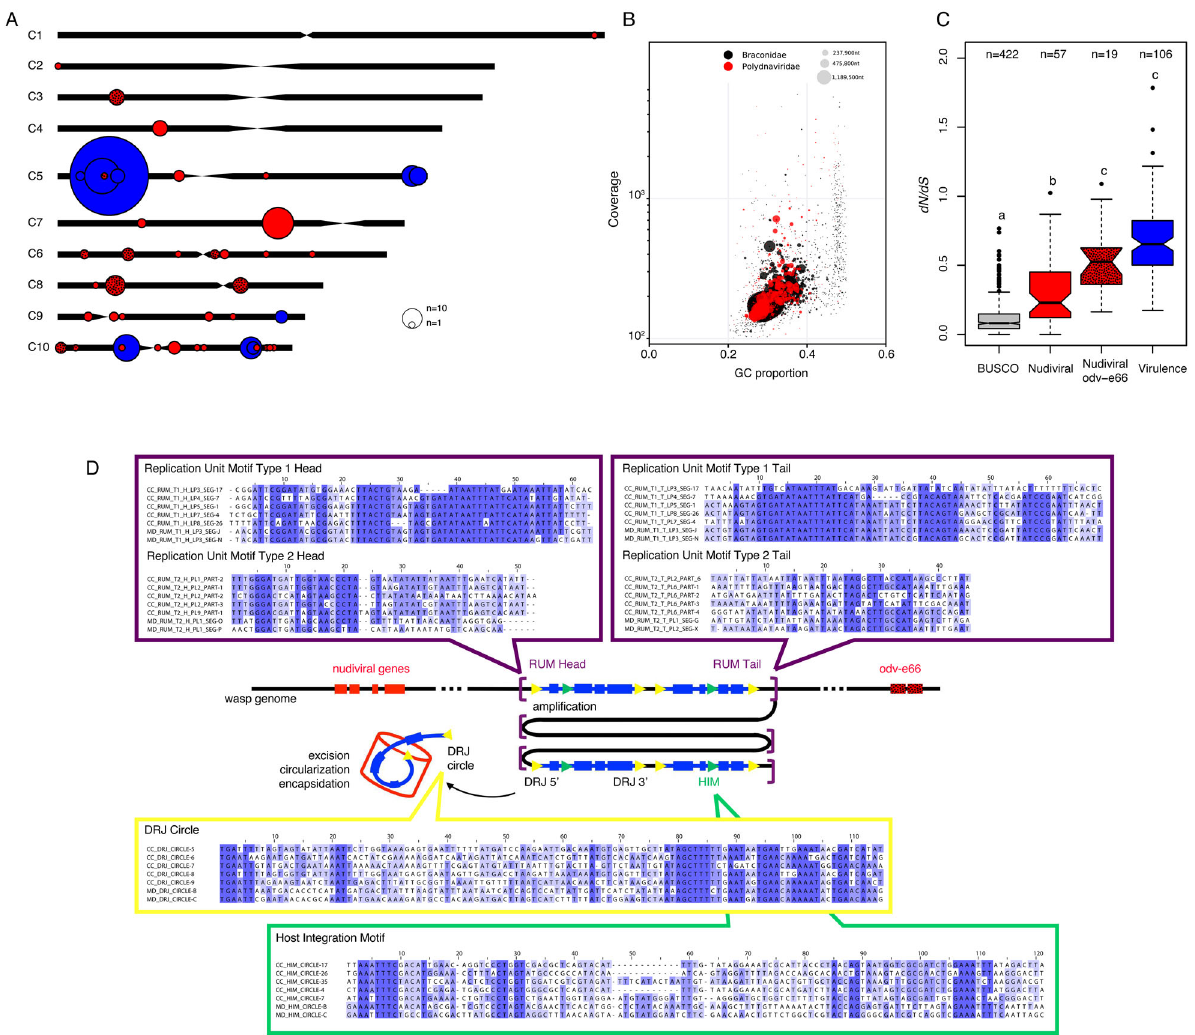
Fig. 4 Bracovirus genes and motifs architecture and evolution. A C. congregata chromosome map with the location of all bracovirus loci: nudiviral gene loci are shown in red, nudiviral odv-e66 gene loci in hatched red and Proviral Loci (PL) in blue. The sizes of the circles correspond to the relative number of genes in each locus B Taxon-annotated GC content-coverage plot of the C. congregata genome associated with Braconidae (in black) and Polydnaviridae (in red). Each circle represents a scaffold in the assembly, scaled by length, and colored by taxonomy assigned by BlobTools. The x -axis corresponds to the average GC content of each scaffold and the y -axis corresponds to the average coverage based on alignment of the Illumina reads. C Measure of selection pressure on hymenopteran conserved genes, nudiviral genes and virulence genes. Pairwise evolutionary rates (d N /d S ) of single-copy orthologous BUSCO genes, nudiviral genes, different copies from the expanded odv-e66 nudiviral gene family and virulence genes of C. congregata and C. sesamiae . Letters above boxes indicate signi fi cant differences determined by Kruskal – Wallis test (H = 296.8, 2 d.f., P < 0.001) followed by post hoc comparisons. D Schematic representation of the genomic ampli fi cation during the production of viral particles in the wasp ovaries. Replication Unit Motifs (RUM) are the motifs that constitute the extremities of the molecules ampli fi ed during particle production. Direct repeat junctions (DRJ), at the extremities of each segment are used during the excision/circularization process to produce packaged dsDNA circles from the ampli fi ed molecules. Host integration motifs (HIM) are motifs used during the integration of bracovirus circles in host genome. For each of these motifs an alignment of a representative set of sequence comprising fi ve motifs from C. congregata and M. demolitor are represented (complete alignments are shown in Supplementary Fig.